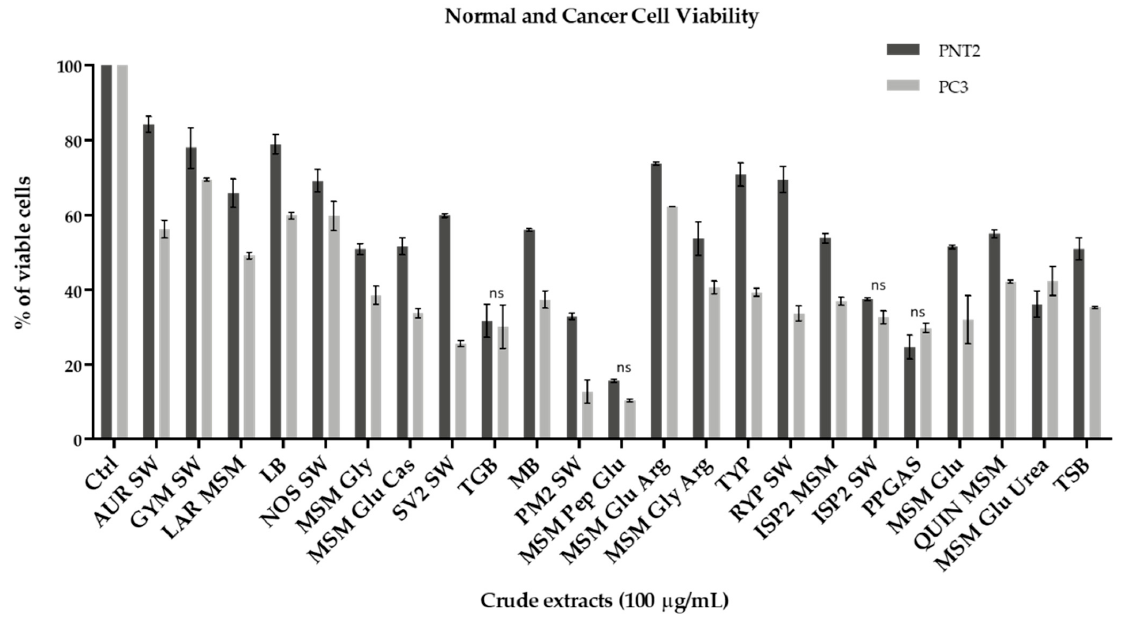
Figure 3. MTT cell viability assay on PNT2 and PC3 cell lines. Histograms represent the percentages of viable cells after 48 h of treatment with 100 µg/mL of crude extracts; assays were performed in triplicate. Cells treated with DMSO vehicle were used as control and correspond to 100% of cell viability. Statistical significances are referred to normal and cancer lines within the same group. Differences between groups were determined by analysis of variance (ANOVA) and Bonferroni test was used as post hoc test. Statistically not significant values are indicated with “ns”, otherwise p < 0.005.